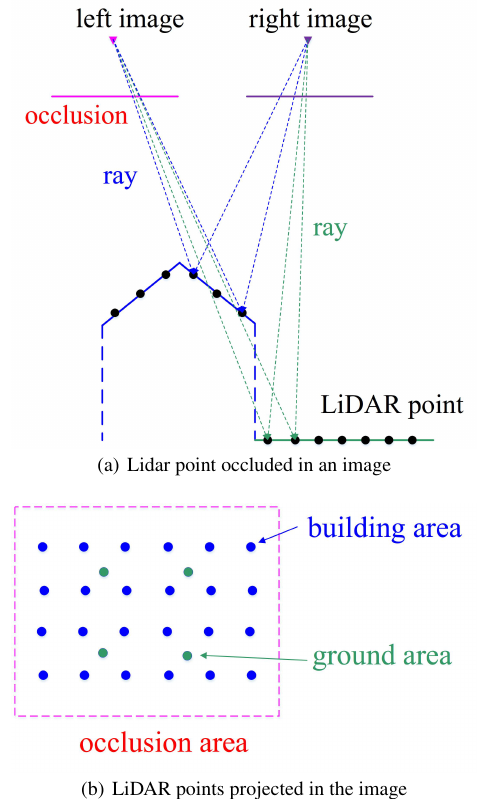
Figure 1. Occlusion in projection.